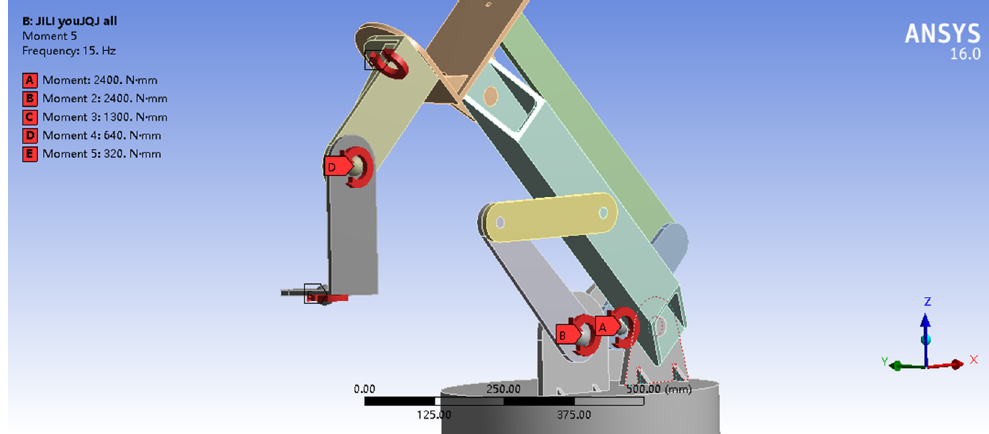
Figure 9. The distribution of excitation sources. The positions of the excitation sources in the model are the positions of the five servo motors. The torque of A and B near the bottom of the base is 2400 N ∙ mm; the torque of C near the connection between the rotating arm and the swing arm g is 1300 N ∙ mm; the torque of D at the connection between the swing arm g and the end g is 640 N ∙ mm; and the torque of E at the end g is 320 N ∙ mm.